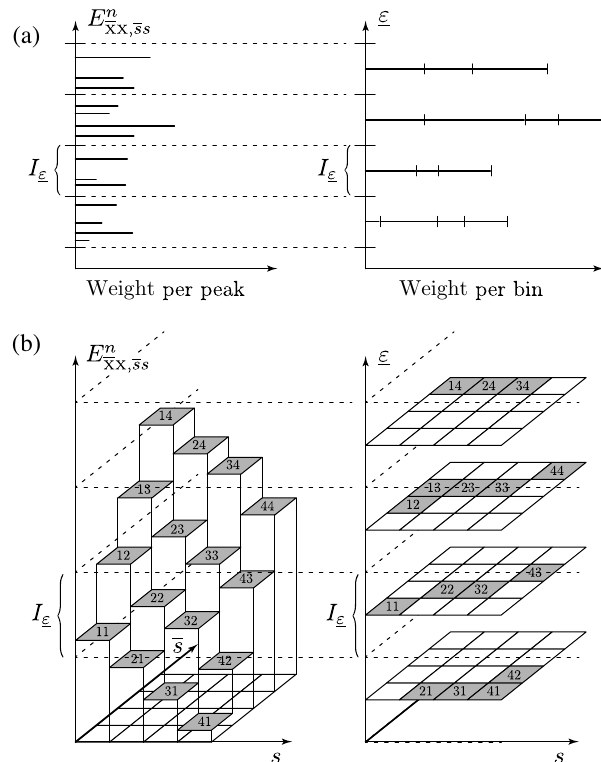
FIG. 1. (a) Binning. Left: Each line represents a δ peak; its length represents the associated weight, its vertical position the transition energy E n ¯ . Right: Peaks lying in the same interval I ε XX ; ¯ ss are treated as having the same energy difference ε ; thus, their weights are added. (b) Slicing. Left: A gray shape labeled s ¯ s represents the matrix element ½ O n ; its horizontal placement (cid:2) s ¯ s X ¯ X reflects the values of the indices s ¯ s , the vertical position the transition energy E n ¯ . Right: Matrix elements with energy XX ; ¯ ss differences lying in the same interval I ε are treated as all having the same energy difference ε and are gathered into a matrix with elements ð½ O n (cid:2) Þ ε s ¯ s X ¯ X points on this axis, Δ ε ¼ ð ln 10 Þ =n , should be much dec narrower than that between the discretized bath energy levels, Δ ¼ ln Λ . In this work we use Λ ¼ 4 and LD n ¼ 32 , yielding Δ ε ¼ 0 . 072 and Δ ¼ 1 . 39 . dec LD